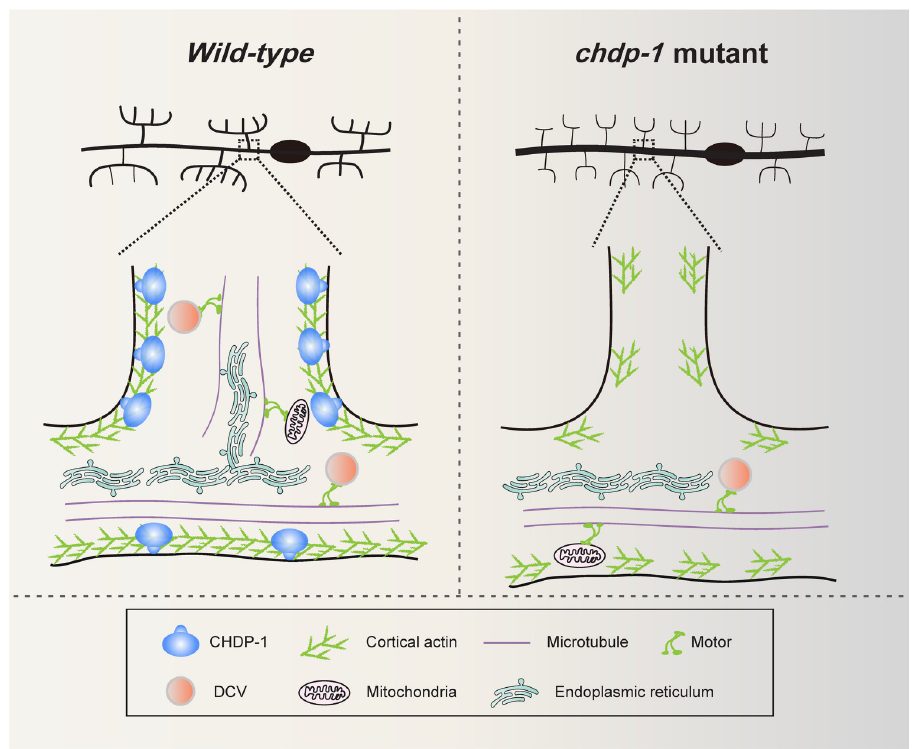
Fig 8. Working model of CHDP-1 in dendrite development and transport. A cartoon showing how CHDP-1 regulates cortical actin assembly in the multi-dendritic neurons. In the wild-type animals, CHDP-1 localizes to the cell cortex and promotes cortical actin assembly. In the high-ordered dendrites, CHDP-1-dependent cortical actin assembly is likely required for microtubule assembly and microtubule-based transport. In chdp-1 knockout animals, cortical actin assembly in the high-ordered branches is reduced, and microtubule assembly and organelle transport are defective. Motor: kinesin or dynein. DCV: dense-core vesicle.